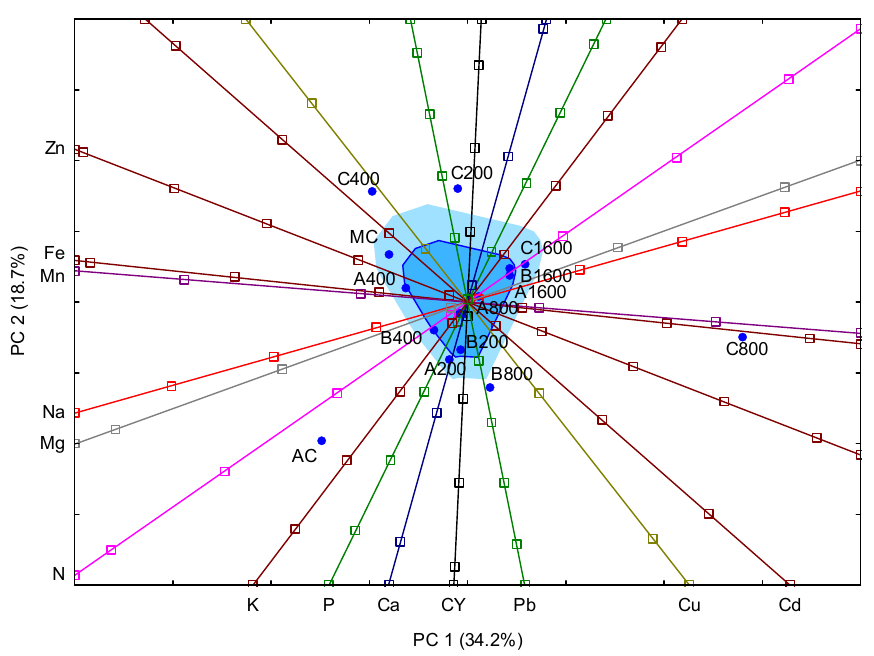
Figure 4. Principal component analysis (PCA) biplot of the tomato commercial yield (CY) and content in fruits of elements. The dark blue square denotes the Tukey median, the blue square is the bagplot, the light blue square is the bagplot cover. Key: A, B and C—bio-fertilizers; AC—absolute control; MC—mineral control.